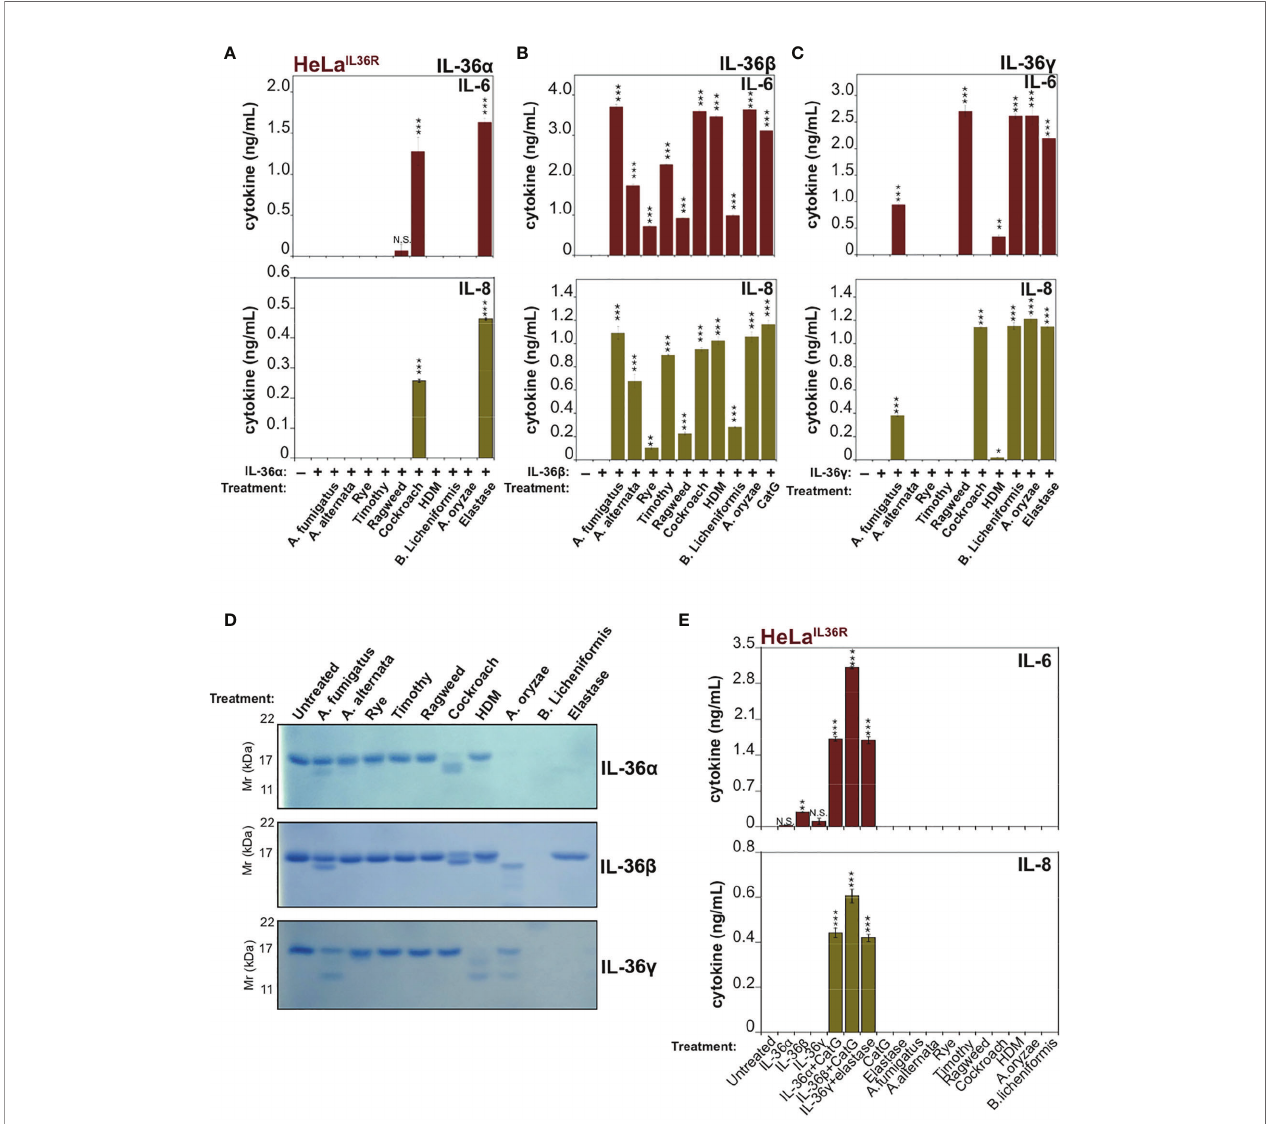
FIGURE 2 | IL-36 family cytokines undergo processing and activation by diverse allergen-associated proteases (A-C) HeLa IL-36R cells were stimulated with 2 nM of either full-length human IL-36 a , IL-36 b or IL-36 g that were pre-incubated for 2 h at 37°C with the indicated allergen extracts (10 m g/mL) or 20 nM of elastase (IL-36 a and IL-36 g ) or 20 nM CatG (IL-36- b ). After 18 h, IL-6 and IL-8 cytokine concentrations in cell culture supernatants were measured by ELISA. (D) Recombinant puri fi ed human IL-36 family cytokines (4 µg per reaction) were incubated with the indicated allergen extracts (20 m g/mL) or 1:500 stock dilution of puri fi ed protease from A. oryzae . As a control, IL-36 a , IL-36 b or IL-36 g were incubated with 50 nM of elastase (IL-36 a and IL-36 g ) or 20 nM CatG (IL-36 b ). Reaction products were analized by SDS-PAGE followed by Coomassie blue stain. (E) HeLa IL-36R cells were incubated, either alone, or with the indicated allergen extracts (all at 10 m g/mL fi nal concentration, with the exception of A. oryzae puri fi ed protease which was used at 1:1000 stock dilution). As positive controls, cells were also incubated with 2 nM of either full-length human IL-36 a , IL-36 b or IL-36 g that were pre-incubated for 2 h at 37 °C with 20 nM of elastase (IL-36 a and IL-36 g ) or 20 nM CatG (IL-36- b ). After 24 h, IL-6 and IL-8 cytokine concentrations in cell culture supernatants were measured by ELISA. Error bars represent the mean of triplicate determinations from representative experiments. ***p < 0.001, **p < 0.01, *p < 0.1, Student ’ s t test. N.S., Not Signi fi